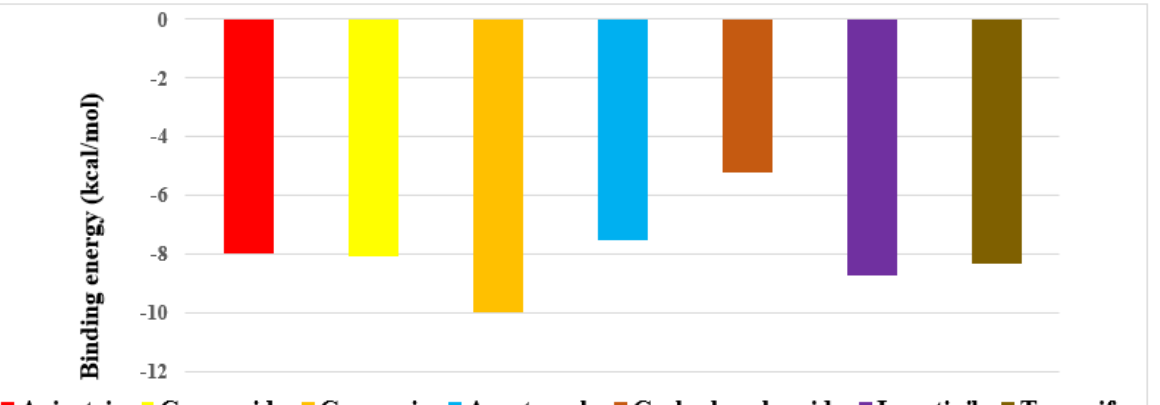
Figure 1. Graphical representation of the binding energy ( − kcal/mol) of the top three phytochemicals (apigetrin, cynaroside and curcumin) and standard drugs (anastrozole, cyclophosphamide, lapatinib and tamoxifen) in complexation with